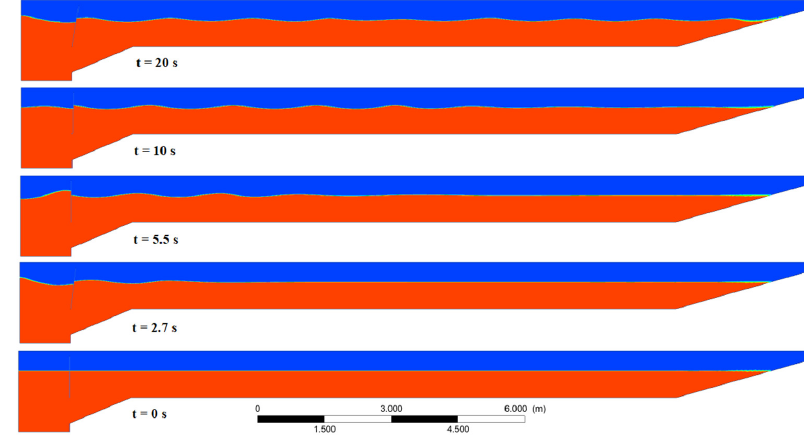
Figure 17. Wave generation by the flap.